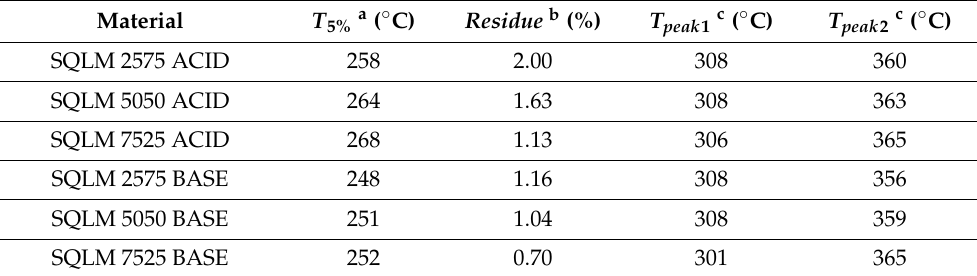
Figure 3. TGA and DTG curves of the materials prepared with acidic ( a , b ) and basic catalysts ( c , d ). Table 2. Main thermal data obtained from TGA tests in nitrogen Table 2. Main thermal data obtained from TGA tests in nitrogen atmosphere.